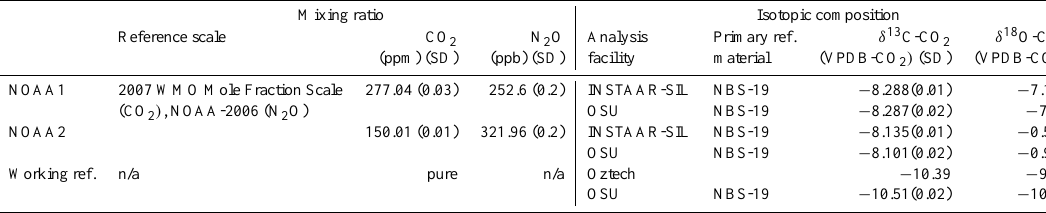
Table 2. Gas concentrations and isotopic composition of reference gases. Mixing ratio Isotopic composition Reference scale CO 2